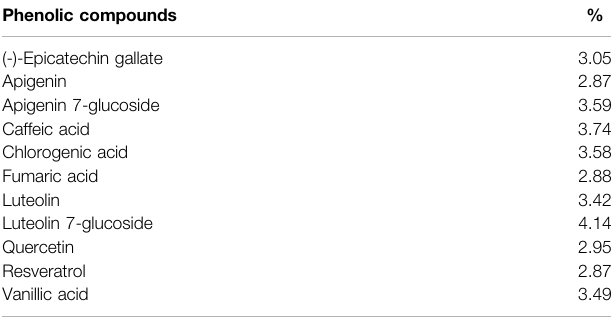
TABLE 2 | Determined phenolic percentage components of grape seed extract. Phenolic compounds % (-)-Epicatechin gallate